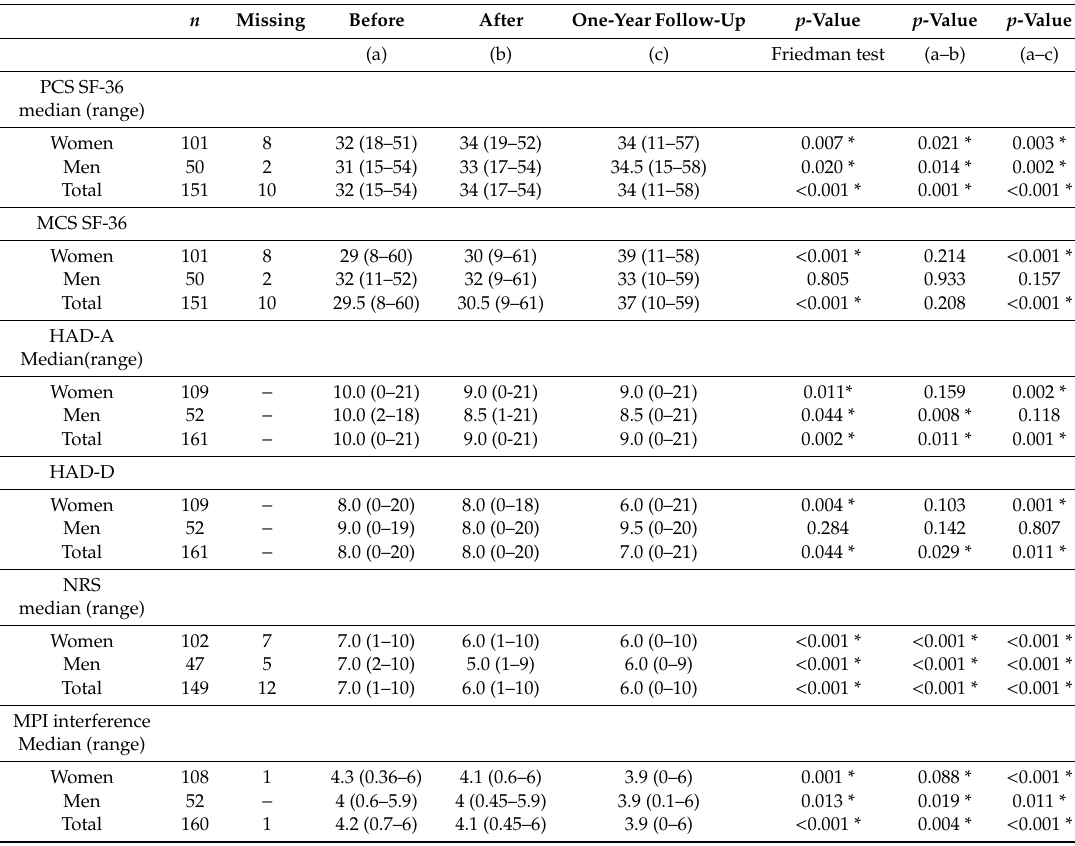
Table 3. Course of whiplash injury patients on self-assessments ( n = 161). Primary and secondary outcomes presented in medians and p-values. Presentation in total and for gender groups before (a), after MMR (b) and at one-year follow-up (c). * denotes significant di ff erence ( p <